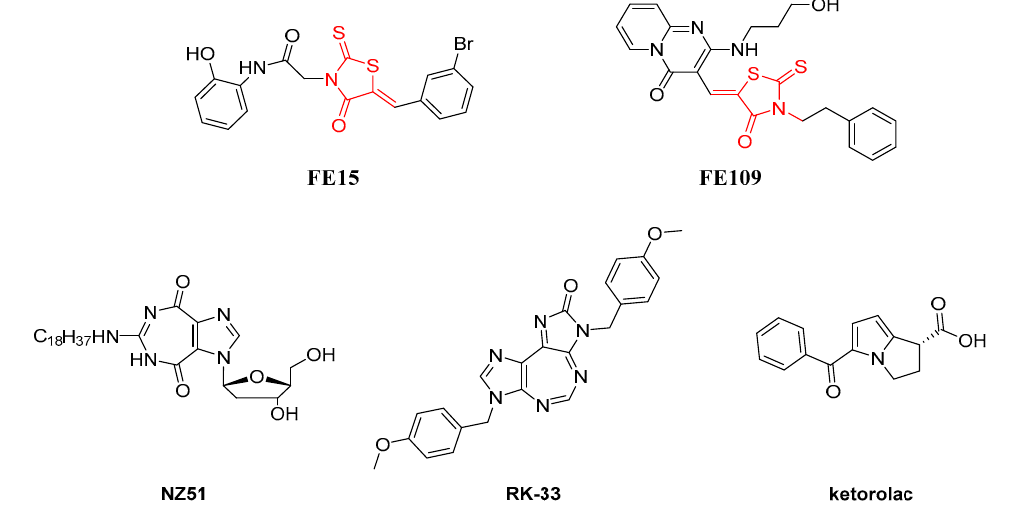
Figure 1. Two-dimensional (2D) Structures of previously identified DDX3X ATPase inhibitors.